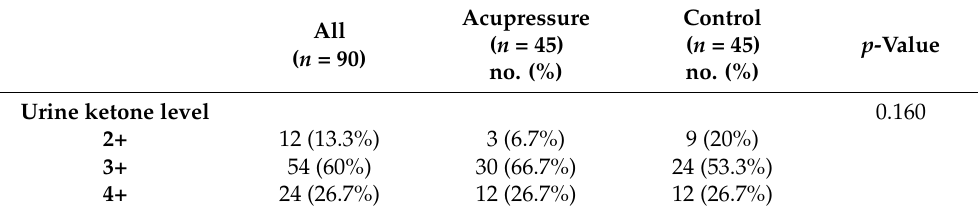
Table 3. Urine ketone levels on